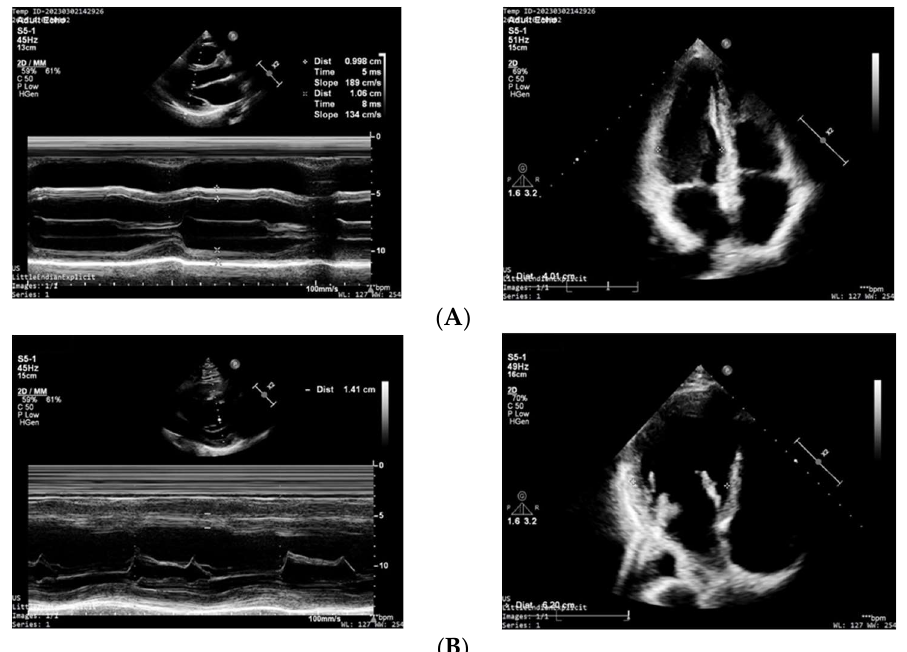
Figure 2. ( A ) Two-dimensional transthoracic echocardiographic image of a CABG patient with tHcy < 12 µM/L. Left panel: parasternal long axis view: normal thickness of interventricular septum (IVS) and posterior wall (PW) can be seen (10 mm). Right panel: Apical four-chamber view shows a normal left-ventricular end-diastolic diameter (LVED = 40 mm). ( B ) Two-dimensional transthoracic echocardiographic image of a CABG patient with tHcy > 12 µM/L. Left panel: Parasternal long axis view: considerably increased (14 mm) thickness of interventricular septum (IVS) and posterior wall (PW) can be seen. Right panel: Apical four-chamber view shows an increased left-ventricular end-diastolic diameter (LVED = 60 mm). Table 2. Echocardiographic data of cardiac patients CABG with tHcy < 12 µ M/L, and CABG tHcy > 12 µ M/L.